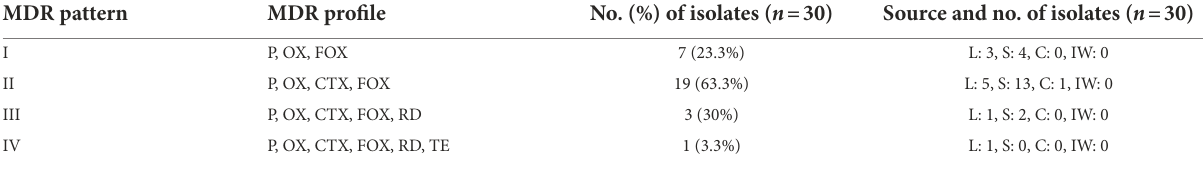
TABLE 7 Multidrug resistance (MDR) patterns of Bacillus cereus group isolates. MDR pattern MDR